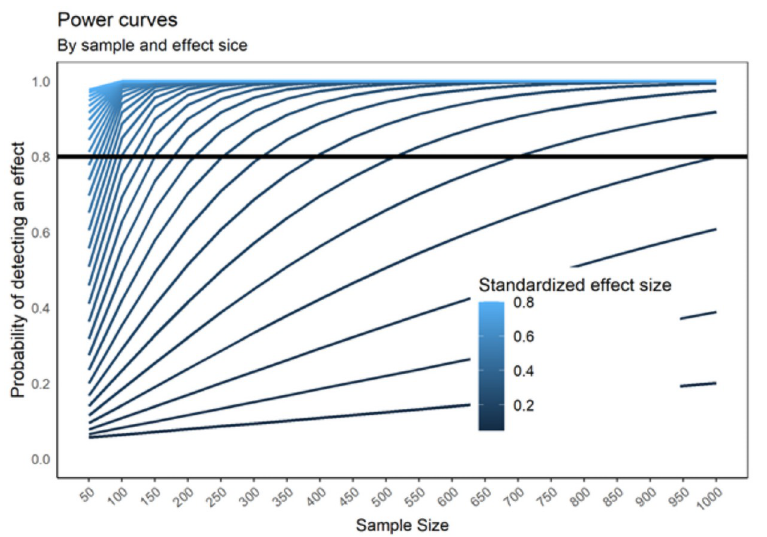
Fig 5. Sample size needed to detect effects of d = 0.2 and